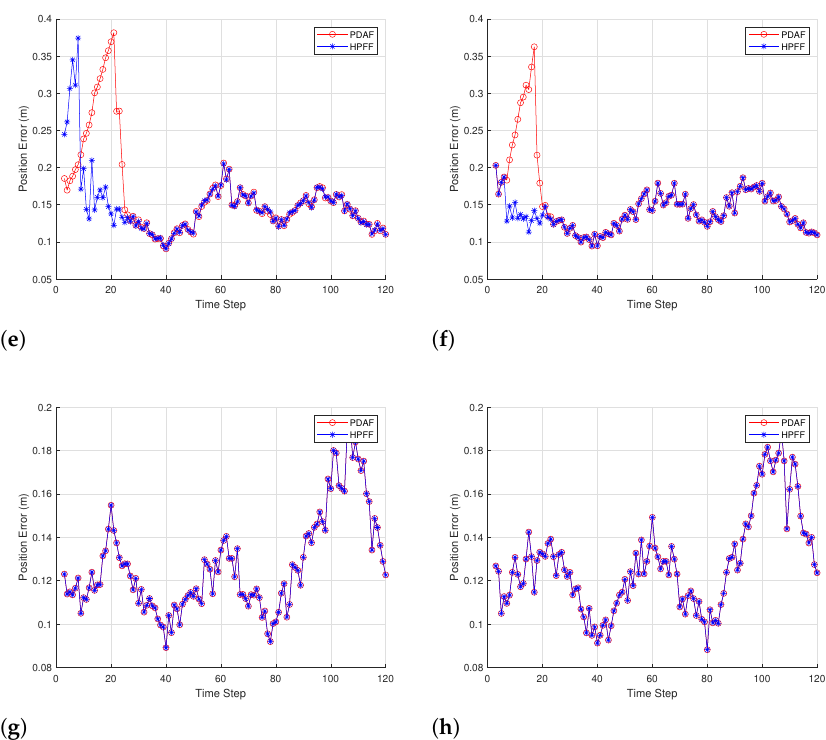
Figure 7. RMS position errors of indoor localization using PDAF and HPFF under constant NLOS conditions in which the transmitter (FN) in a NLOS was ( a ) FN1, ( b ) FN2, ( c ) FN3, ( d ) FN4, ( e ) FN5, ( f ) FN6, ( g ) FN7, and ( h )